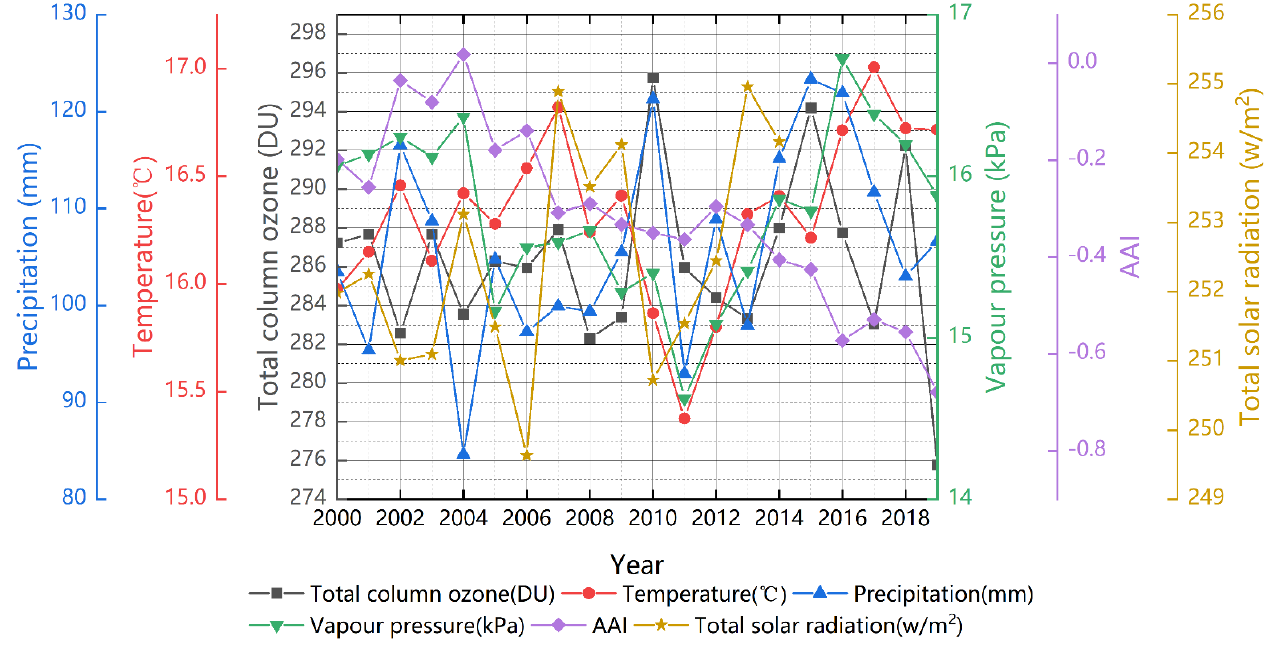
Figure 2. A line chart of the annual variation in the TCO and the meteorological factors over the Yangtze River Delta Urban Agglomerations during 2000 – 2019.